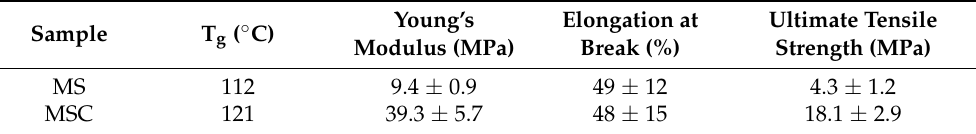
Figure 2. ( a ) DSC thermogram of MS and MSC; ( b ) Stress–strain curve of MS and MSC. ( b-1 ) tensile fracture image. Table 1. Thermal and mechanical properties of the MSC.